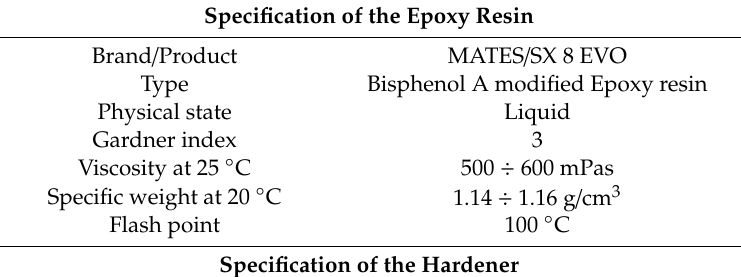
Figure 1. Block diagram of the manufacturing processes of the three batches of samples with different levels of CNTs dispersion. Table 1. Properties of the bi-component epoxy resin and of the Multi-wall Carbon